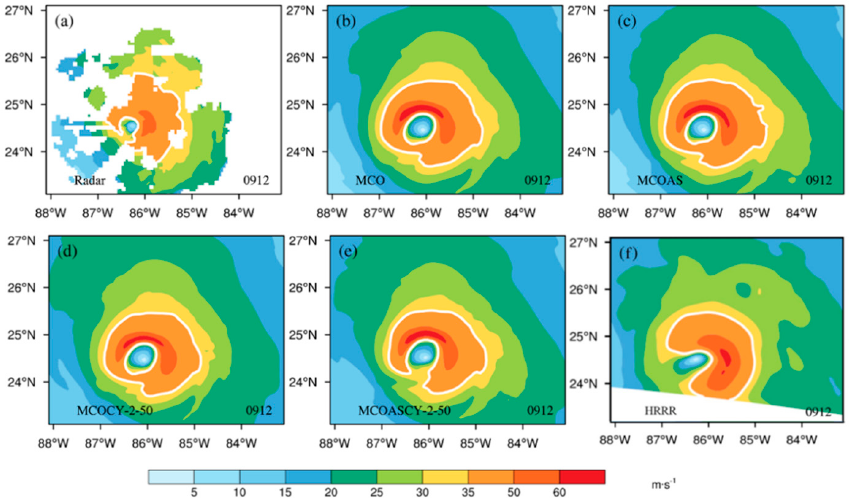
Figure 3. ( a ) NOAA P3 Radar horizontal wind field at 500 m and horizontal wind analysis field (unit: m · s − 1 ) at the 17th eta level (approximately 925 hPa) for Michael at 1200 UTC 9 October 2018. Panels ( b – e ) represent Exp. MCO, Exp. MCOAS, Exp. MCOCY-2-50, and Exp. MCOASCY-2-50, respectively. Panel ( f ) denotes HRRR analysis at 925 hPa.